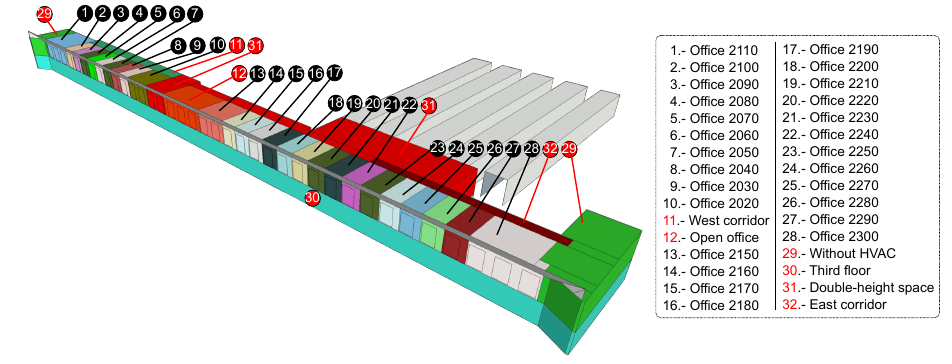
Figure 2. “Amigos” building elevation.